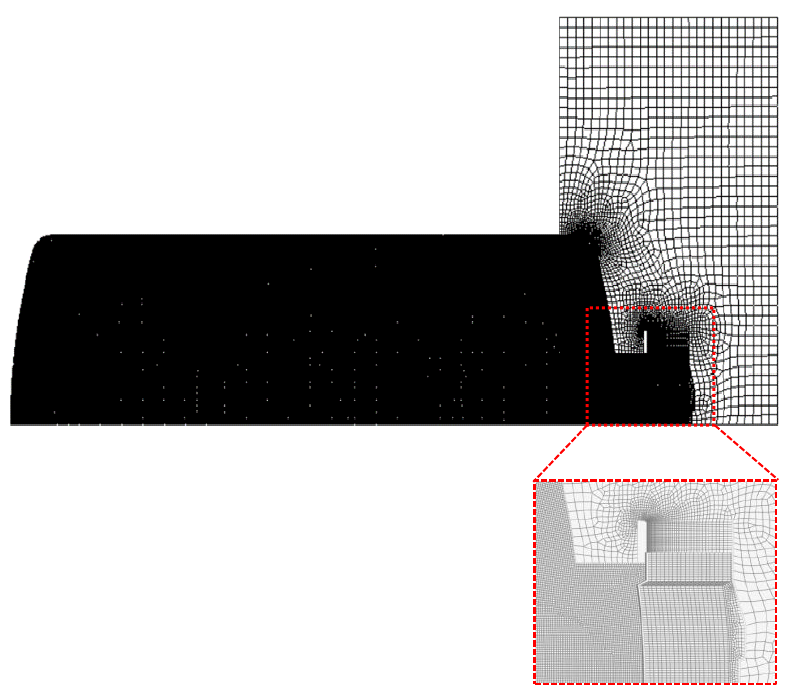
Figure 2. Mesh modeling for the crankcase explosion relief valve with the chamber.